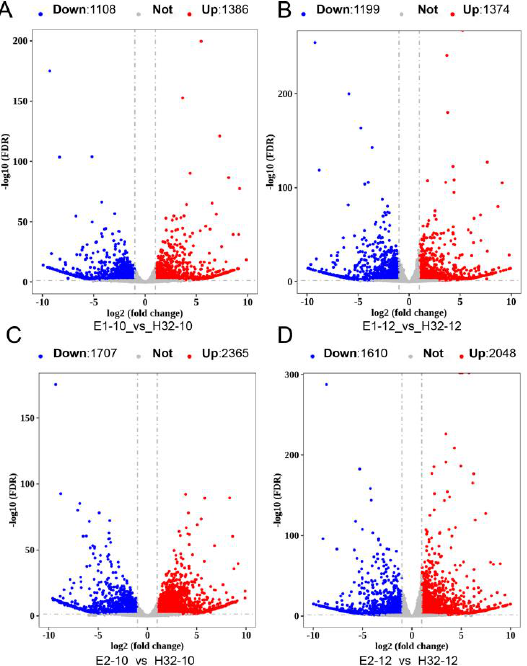
Figure 1. Volcano map of DEGs. ( A ) Volcano map of DEGs in E1-10_vs_H32-10; ( B ) Volcano map of DEGs in E1-12_vs_H32-12; ( C ) Volcano map of DEGs in E2-10_vs_H32-10; ( D ) Volcano map of DEGs in E2-12_vs_H32-12; The red, blue, and gray dots represent up-regulated DEGs (Up), down- regulated DEGs (Down), and not change genes (Not), respectively.